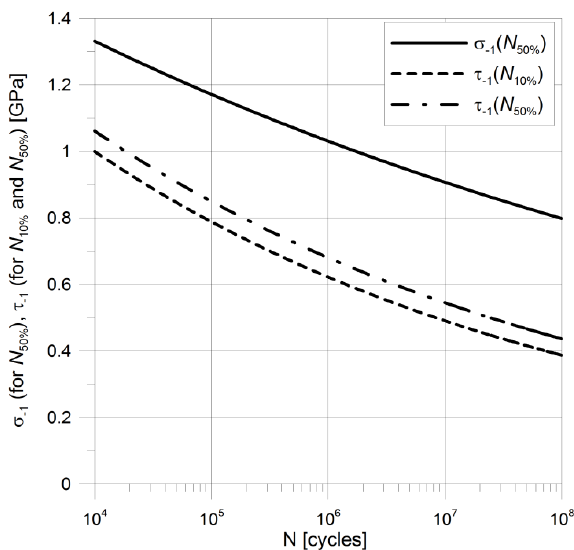
Figure 4. SN curves for AISI 52100 in alternating axial and alternating torsion loading for 10% failure life ( N 10% ) and 50% failure life ( N 50% ).